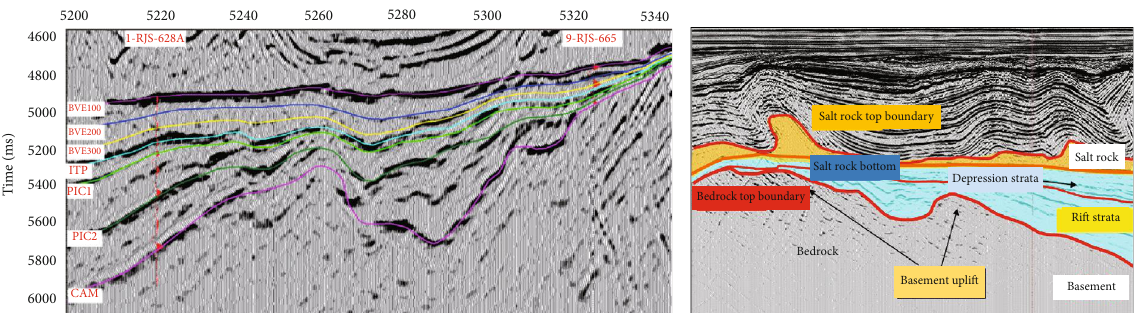
Figure 5: Map of the presalt stratigraphy in the Santos